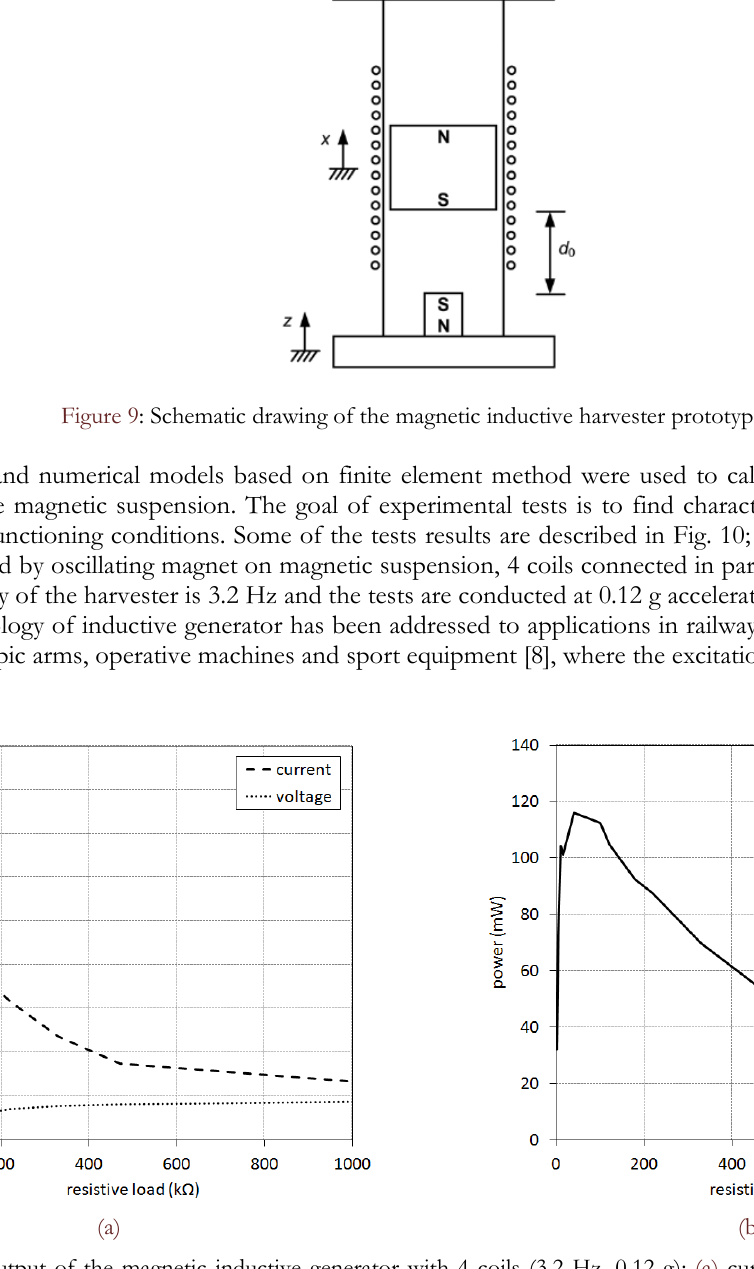
Figure 10: Electric output of the magnetic inductive generator with 4 coils (3.2 Hz, 0.12 g): (a) current and voltage and (b) output